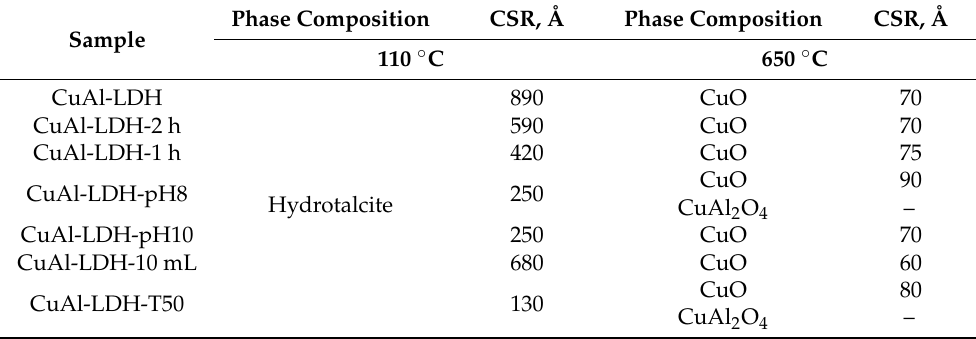
Table 2. Phase composition and coherent scattering region of the